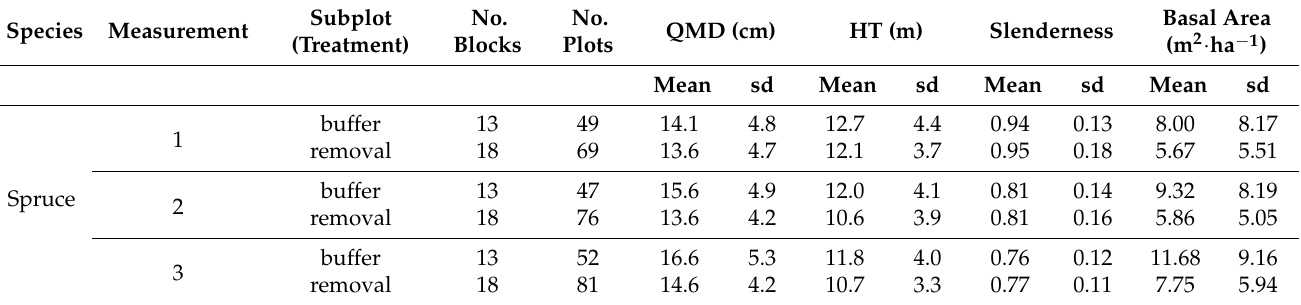
Table 2. Treatment means and standard deviations for spruce size by measurement. Tagging limit is ≥ 7.1 cm DBH for all measurements. Note: Plots with no spruce trees were excluded from this analysis; the period between Measurements 1 and 2 ranged from 5 to 7 years; between Measurements 2 and 3, it was 5 years. Overall, between Measurements 1 and 3, the period ranges from 10 to 12